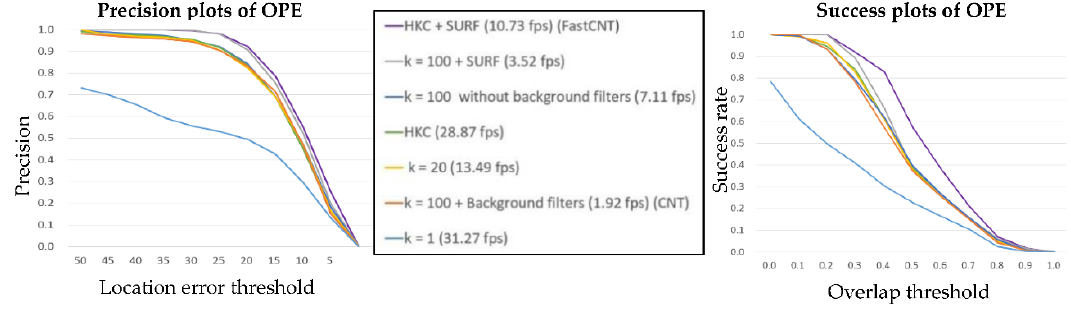
Figure 6. The success and precision plots of OPE for the top 6 experimental trackers.